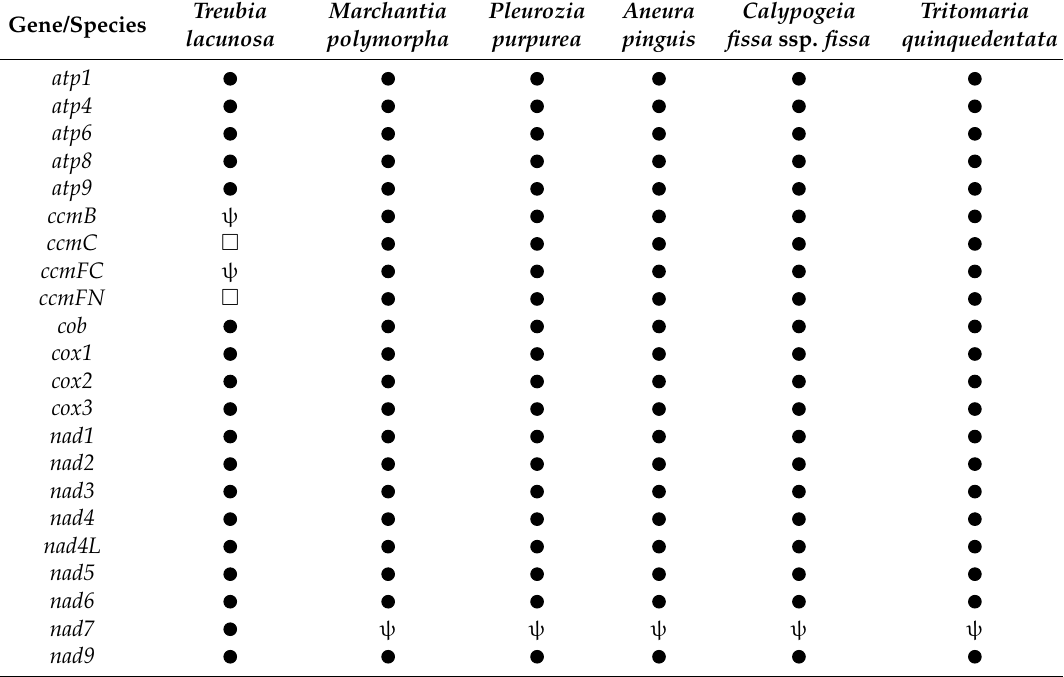
Table 2. Gene contents in liverwort mitochondrial genomes. The black circle or “ ψ ” indicate the presence of a functional gene or a pseudogene, respectively. The white square indicates a gene lacking. Two black circles indicate the presence of a duplicated copy. a The gene rtl may be pseudogenized [36].